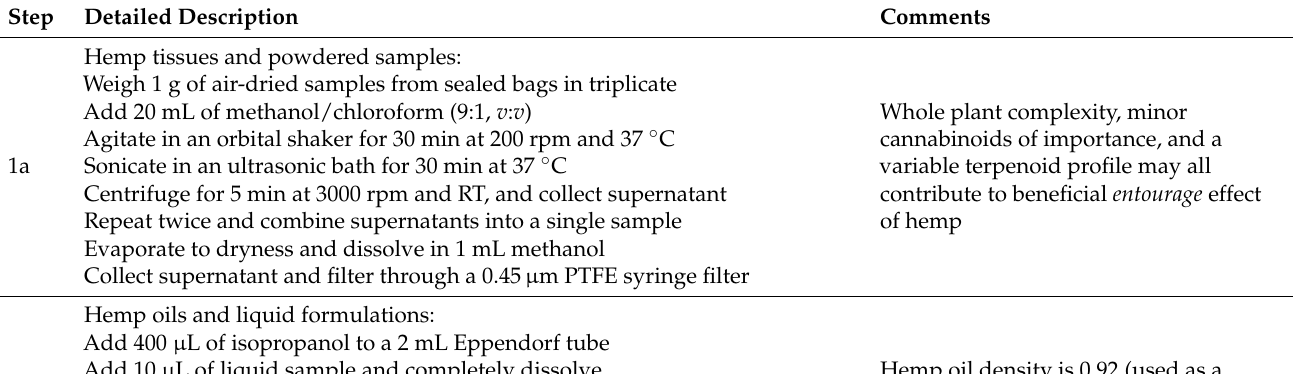
Table 1. Analytical workflow for HPLC-UV quantitative determination of 11 major cannabinoids in cannabis, its derivative extracts, oils, formulations, and biological test